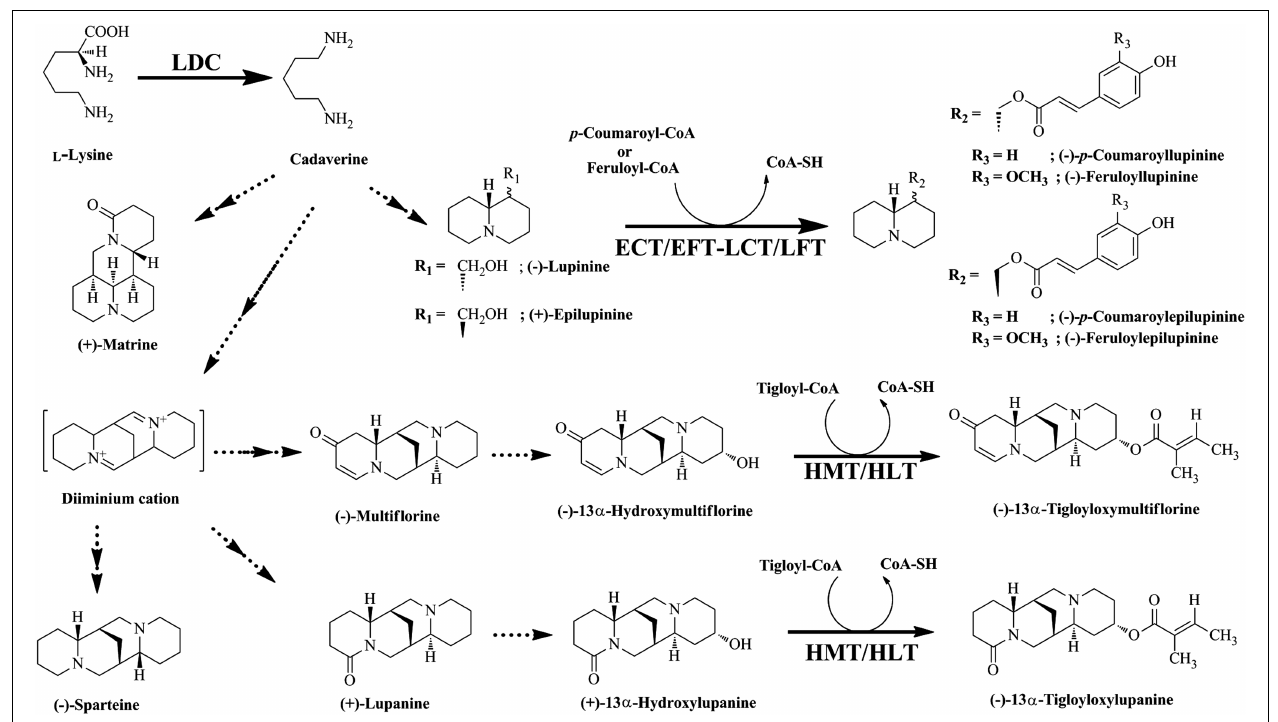
these alkaloids are indicated: LDC, Lys decarboxylase; HMT/HLT, tigloyl-CoA: ( − )-13 α -hydroxymultiflorine/( + )-13 α -hydroxylupanine O